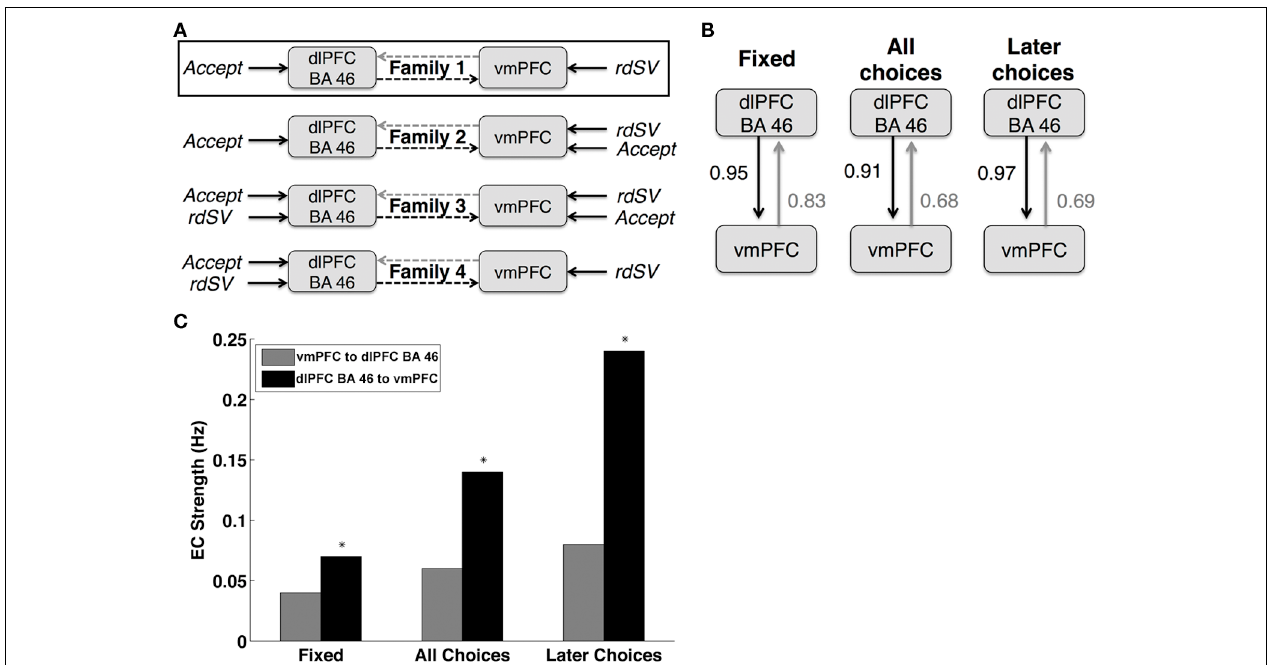
FIGURE 6 | Dynamic causal modeling results. (A) Schematic representations of the four DCM families compared in order to optimize the task related driving input to dlPFC BA 46 and vmPFC. Bayesian Model comparison showed that Family 1, outlined in black, was the most likely description of the data generating process. (B) Diagram of the fully connected model from the most likely family showing the posterior probabilities of coupling or coupling modulation greater than zero between vmPFC to dlPFC BA 46. Fixed refers to the baseline coupling during all time points. All Choices refers coupling modulation at the time